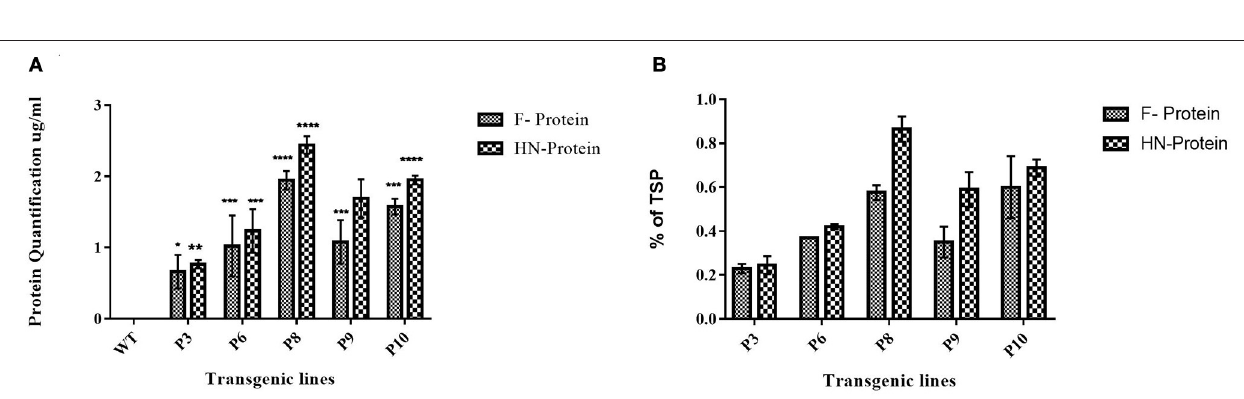
FIGURE 5 | Expression analysis of F and HN gene through Real Time PCR. (A) cDNA was synthesized from transgenic plants and expression of F gene was studied at transcription level. The maximum expression of 7-fold in P8 and P10 was observed as compared to 5-fold in P3, 6-fold in P6 and P9. (B) cDNA was synthesized from transgenic plants and expression of HN gene was studied at transcription level. 28-fold expression of HN mRNA in P8, 25-fold in P10, 13-fold in P9 was obtained as compared to P3, P6 where it remained 8–9-fold. Data shown are average ± SD of three biological replicates. The significance of the data is determined by one-way ANOVA and p < 0.0001 is indicated by “****” and p < 0.001 is indicated by “***” above bars.